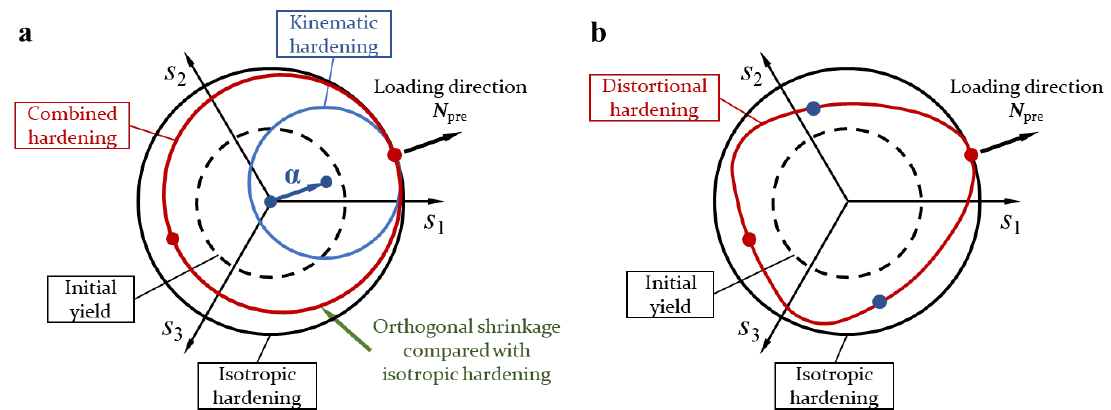
Figure 2. Evolution of the yield surface according to the type of hardening: ( a ) kinematic hardening and ( b ) distortional hardening.